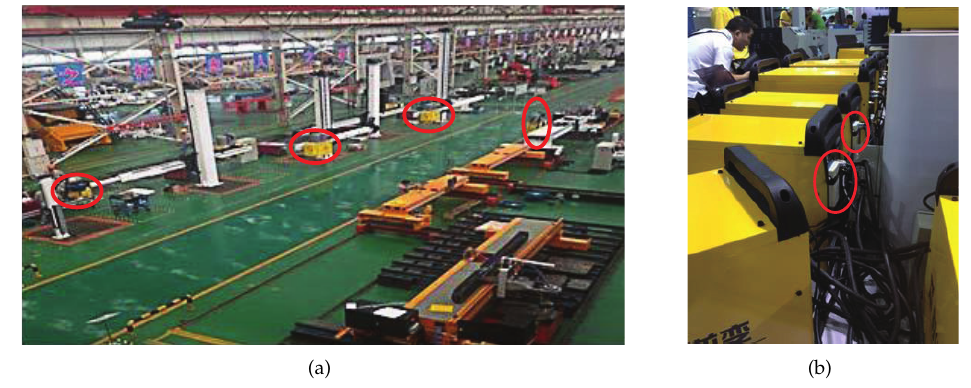
Figure 15. ( a ) The site of implementation and ( b ) the welder machine with the W-CAN node.